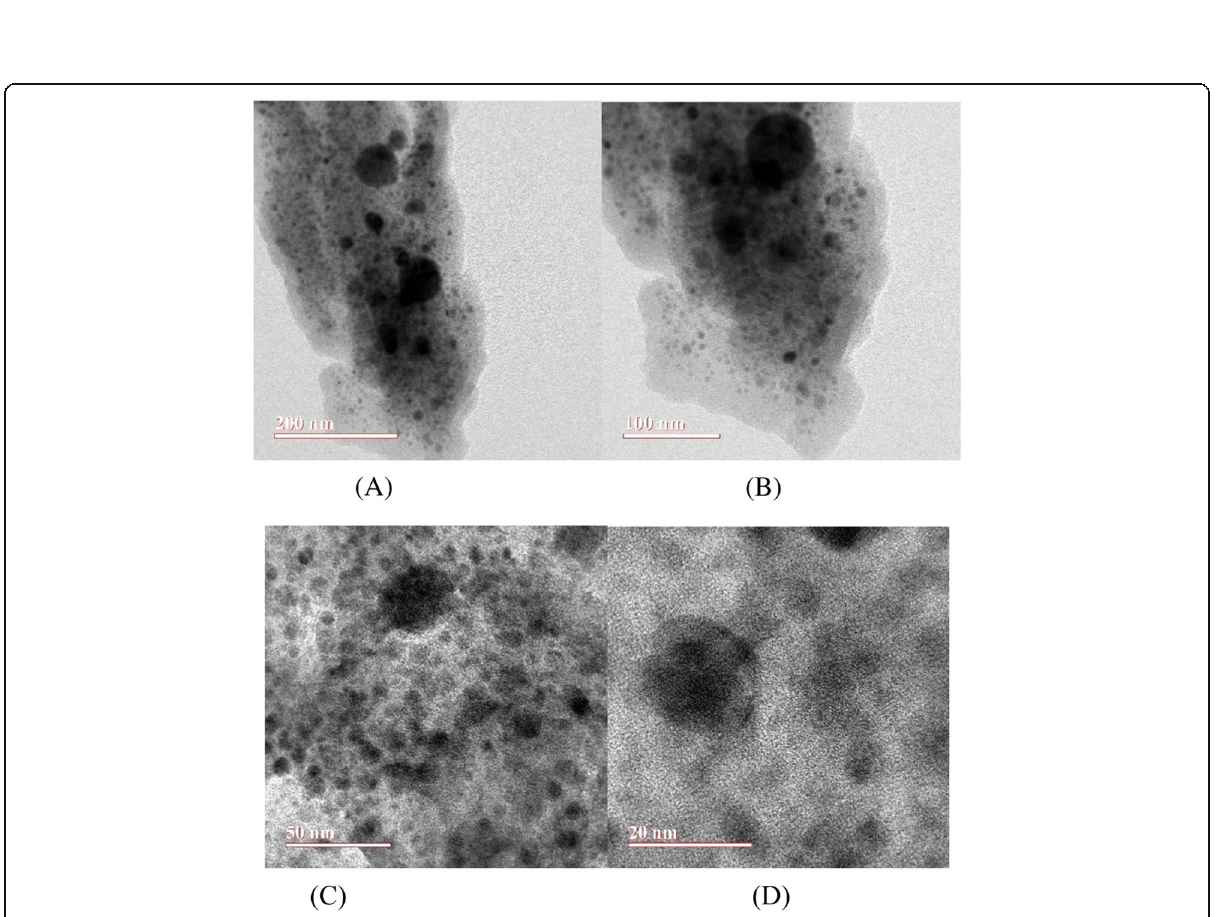
Fig. 3 TEM images of Zinc Nanoparticles at different scale. a 200 nm ( b ) 100 nm ( c ) 50 nm ( d ) 20 nm